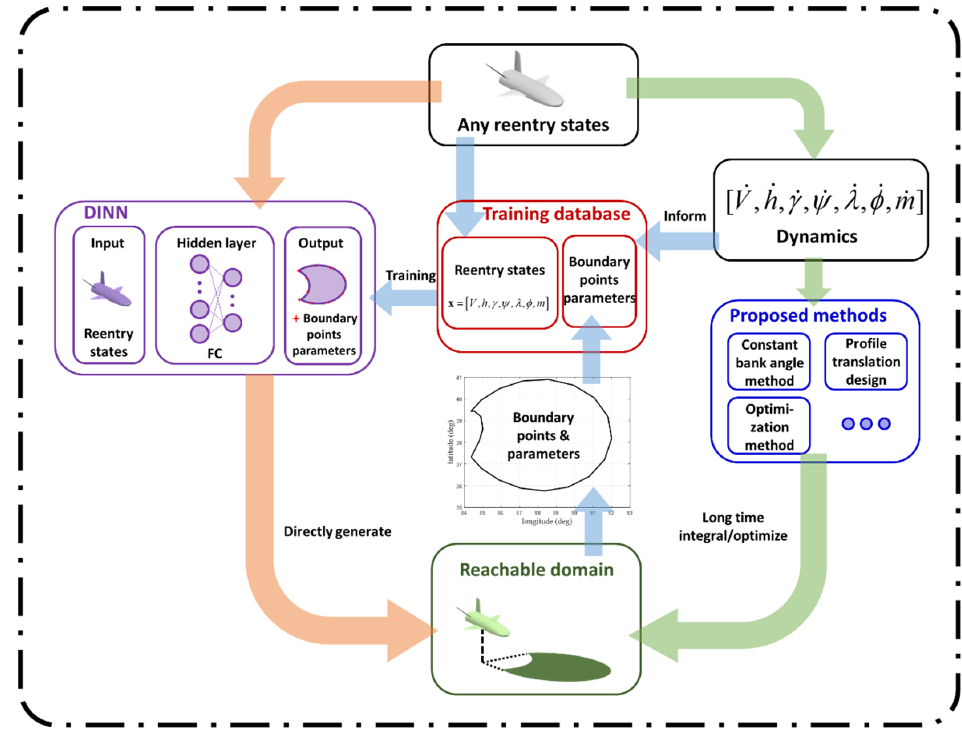
Figure 2. A framework for solving the reachable domain based on DINN.